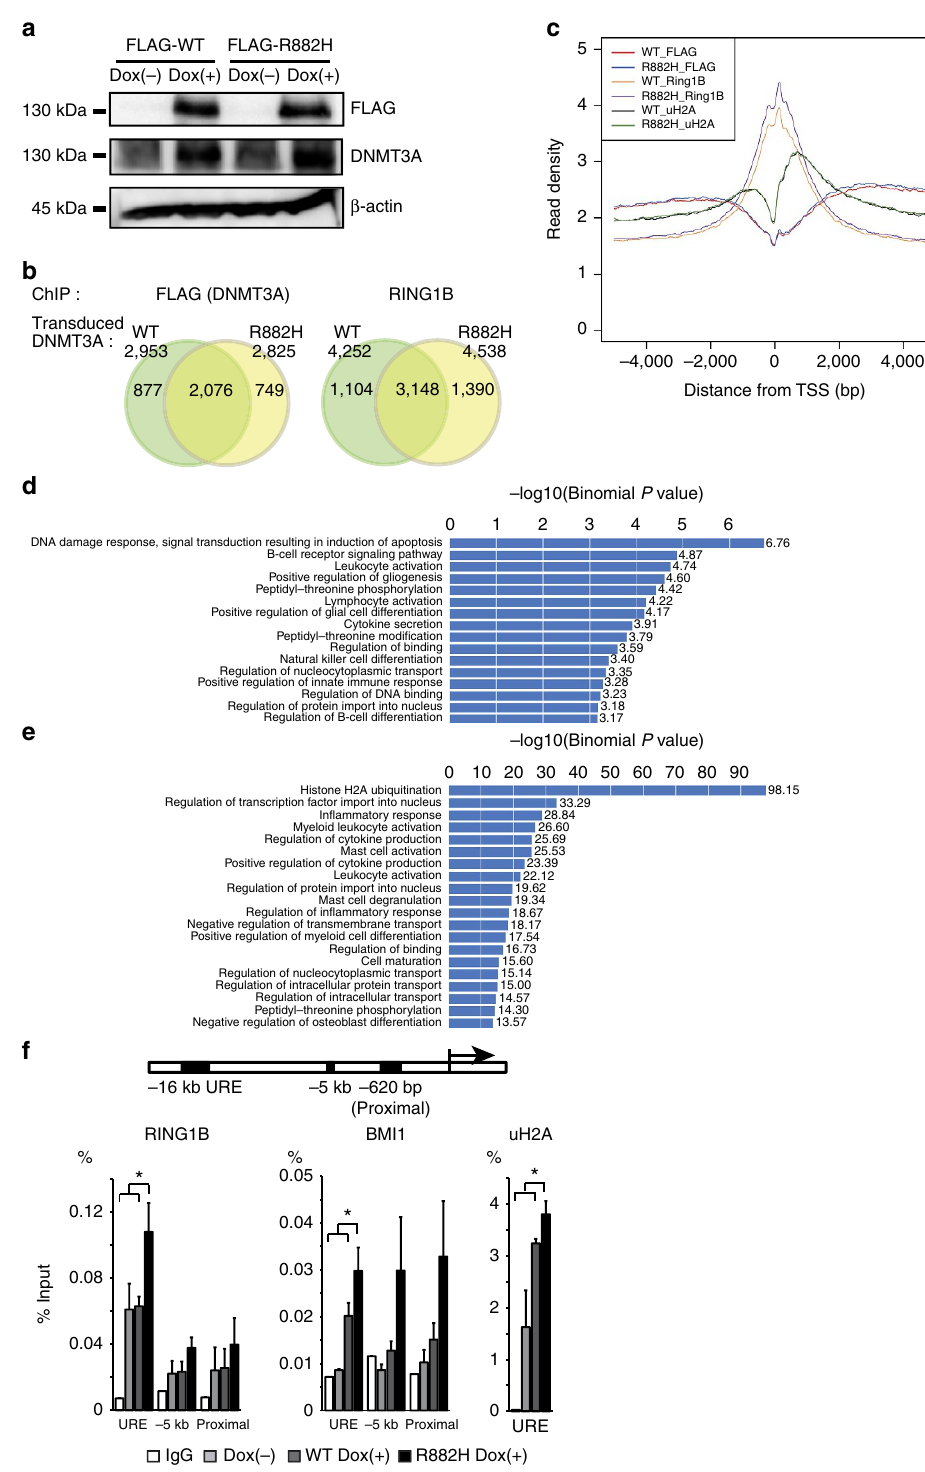
Figure 5 | DNMT3A R882 mutant recruits more efficiently RING1B to cell differentiation-associated genes. ( a ) Protein expression of HL-60 cells transduced with Dox-inducible FLAG-tagged WTor R882H with or without administration of Dox using anti-FLAG and anti-DNMT3A antibody. b -actin was used as a loading control. ( b ) Venn diagrams showing numbers and overlap of target genes of DNMT3A (left) and RING1B (right) on expression of WTand R882H. ( c ) Normalized read densities of DNMT3A, RING1B and uH2A in WT- or R882H-transduced HL-60 cells. ( d , e ) Lists of gene ontology terms in biological process by GREATanalysis derived from the regions targeted by both R882H and RING1B ( d ), and R882H and ubiquitinated H2A ( e ). ( f ) ChIP- qPCR experiment of the PRC1 components RING1B, BMI1 and ubiquitinated H2A in HL-60 cells at the URE, a 5-kb upstream region, and proximal promoter region of PU.1 in the absence of or in the presence of either Dox-inducible WTor R882H. ( N ¼ 3 replicate experiments except for IgG control ( N ¼ 1) and ubiquitinated H2A in Dox( (cid:2) ) ( N ¼ 2).) P values were calculated using two-tailed unpaired t -test. ChIP-qPCR, chromatin immunoprecipitation-quantitative polymerase chain reaction; Dox, doxycycline; PRC1, polycomb repressive complex1; WT, wild type. Data are mean ± s.d. values. * P o